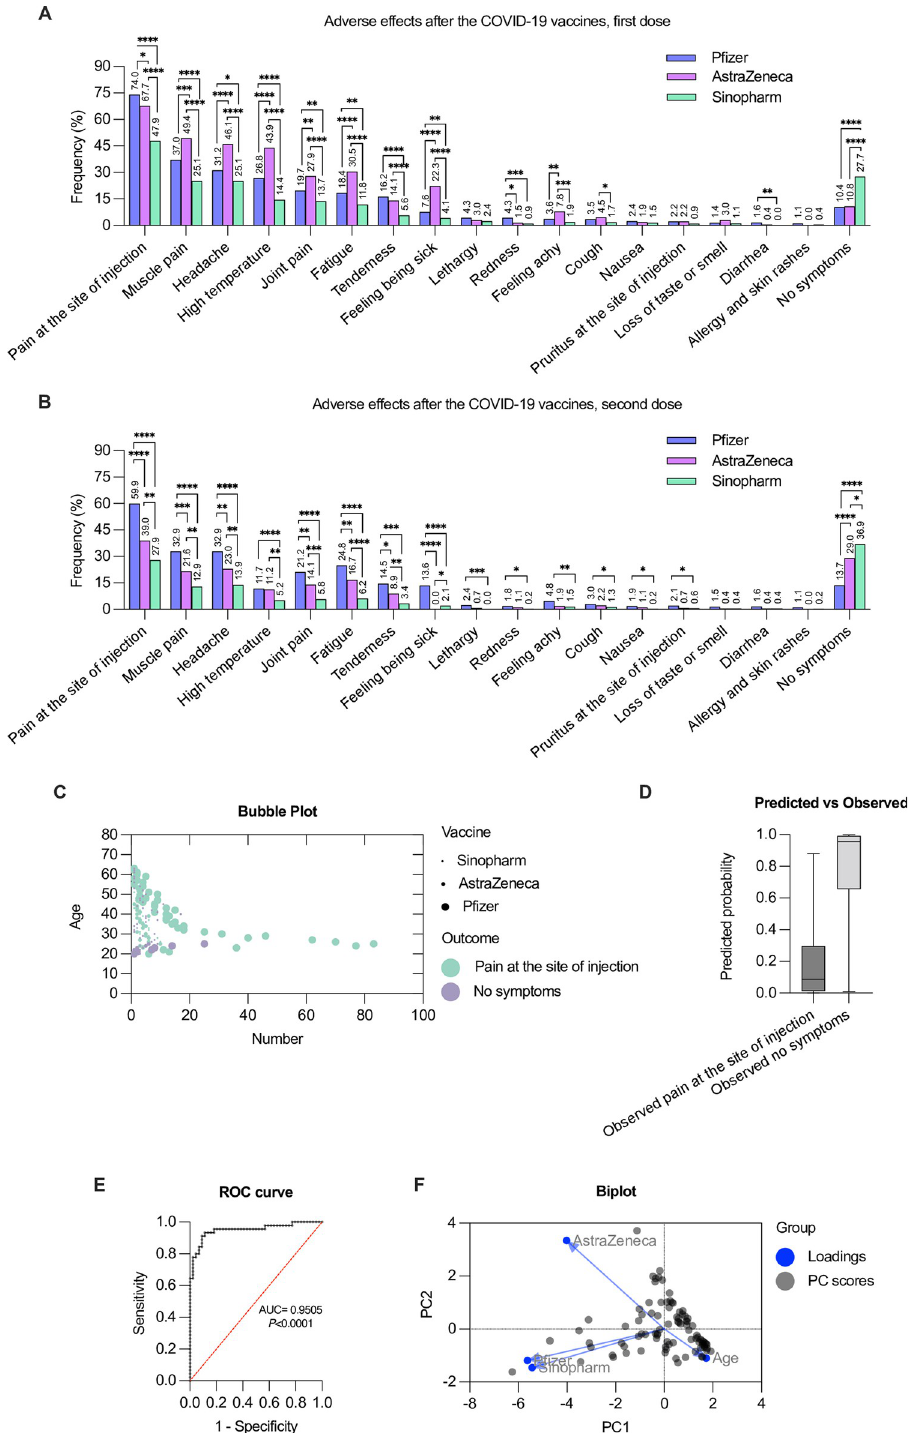
Fig 4. Prevalence of the COVID-19 vaccines adverse effects (percentage) associated with various vaccine types (Pfizer, AstraZeneca and Sinopharm) among vaccinated participants. (A) after the first dose, (B) after the second dose. A statistical analysis of the adverse effects associated with various COVID-19 vaccines (Pfizer versus AstraZeneca, Pfizer versus Sinopharm, AstraZeneca versus Sinopharm) was performed using the chi-squared test. � p < 0.05, �� p < 0.01, ��� p < 0.001 and ���� p < 0.0001. (C) A bubble chart depicting the association between the significant outcomes of the vaccinated population, age and type of vaccine. (D) Predicted probability chart analysis